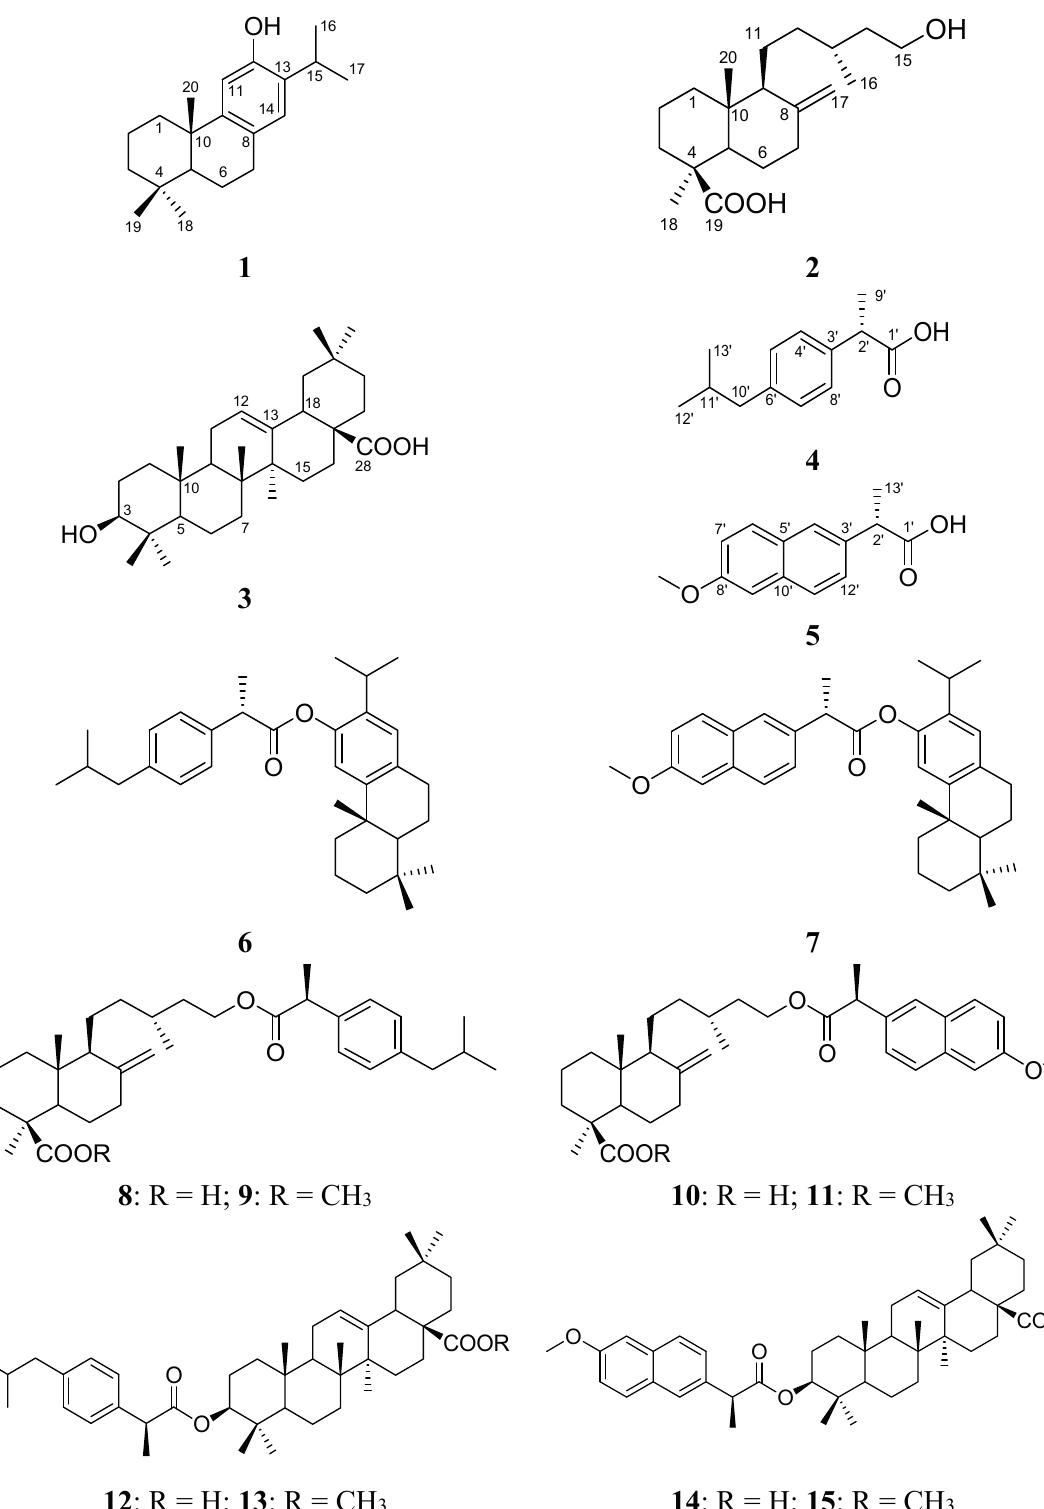
Figure 1. Structure of the starting terpenes 1 – 3 , synthetic anti-inflammatory drugs 4 , 5 and the new compounds 6 – 15